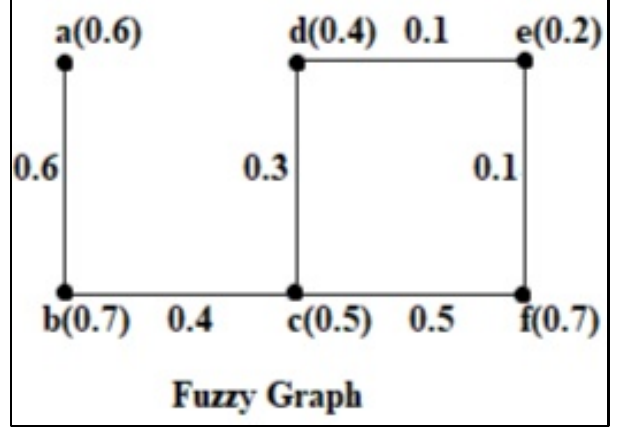
Figure 1. Fuzzy graph.